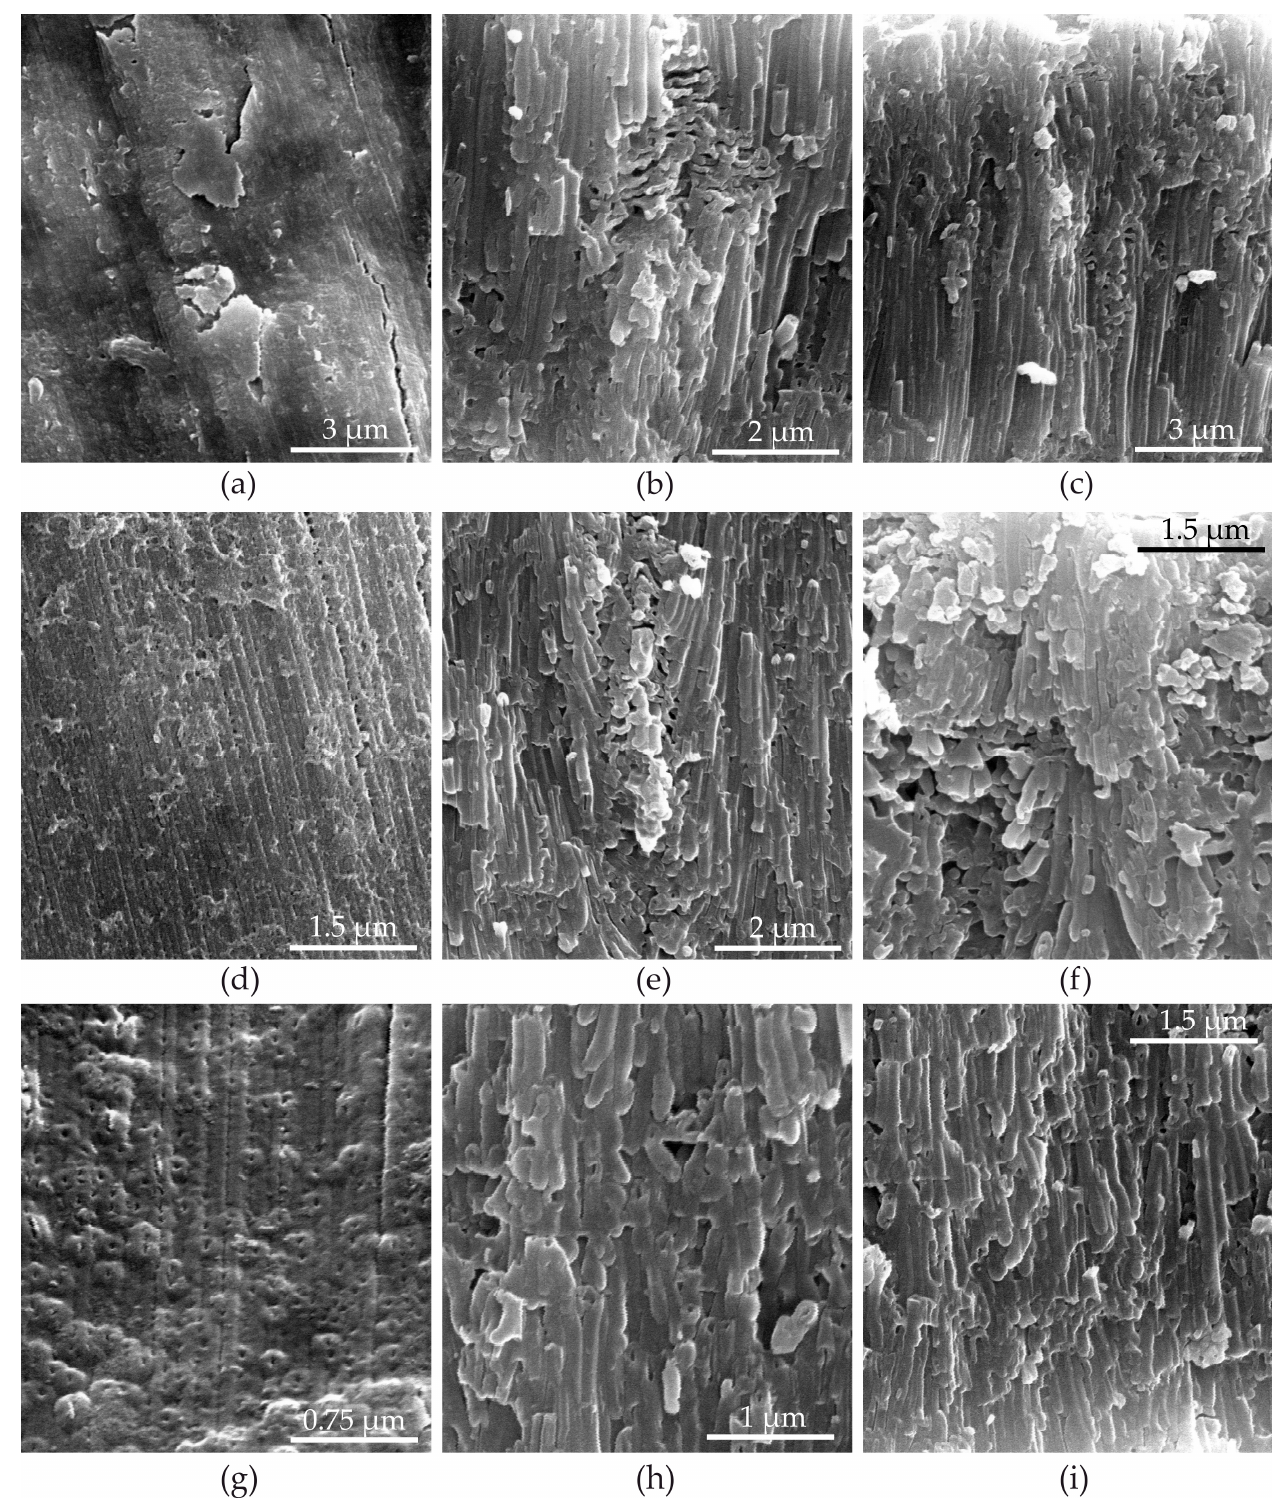
Figure 15. SEM images at various resolutions of porous aluminum oxide film surface ( a ) and cross-sections ( b , c ) formed in galvanostatic mode in 0.6 M malonic acid at an anodic current density of 15 mA·cm –2 with 3.42 g·L –1 arsenazo-I additive, porous aluminum oxide film surface ( d ) and cross-sections ( e , f ) formed at an anodic current density of 100 mA·cm –2 with 3.72 g·L –1 arsenazo-I additive, and porous aluminum oxide film surface ( g ) and cross-sections ( h , i ) formed at an anodic current density of 200 mA·cm –2 with 4.0 g·L –1 arsenazo-I additive.